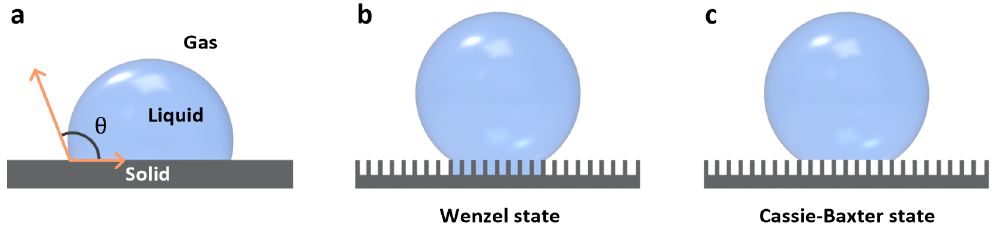
Figure 2. Schematic representations of a water droplet on flat and rough solid surfaces. ( a ) A droplet on an ideal flat surface; ( b ) A droplet in the Wenzel state, in which the rough surface is fully wetted; ( c ) A droplet in the Cassie ‐ Baxter state, in which air pockets form at the interface between the non ‐ wetted rough surface and droplet.